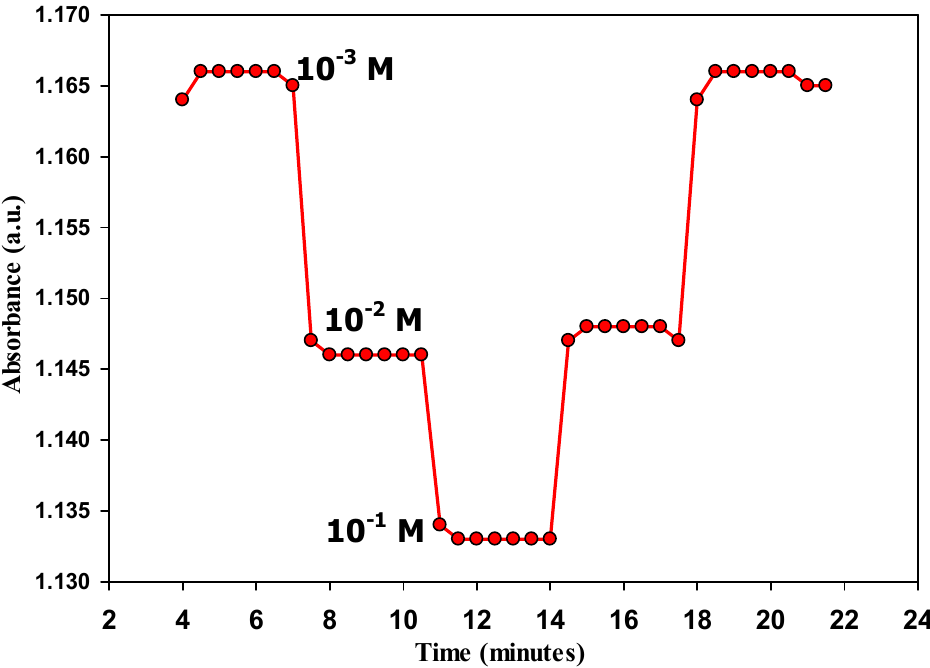
Figure 6. Reversibility and response time of optode 3 in response to different glucose solutions (10 − 3 M, 10 − 2 M, and 10 − 1 M).